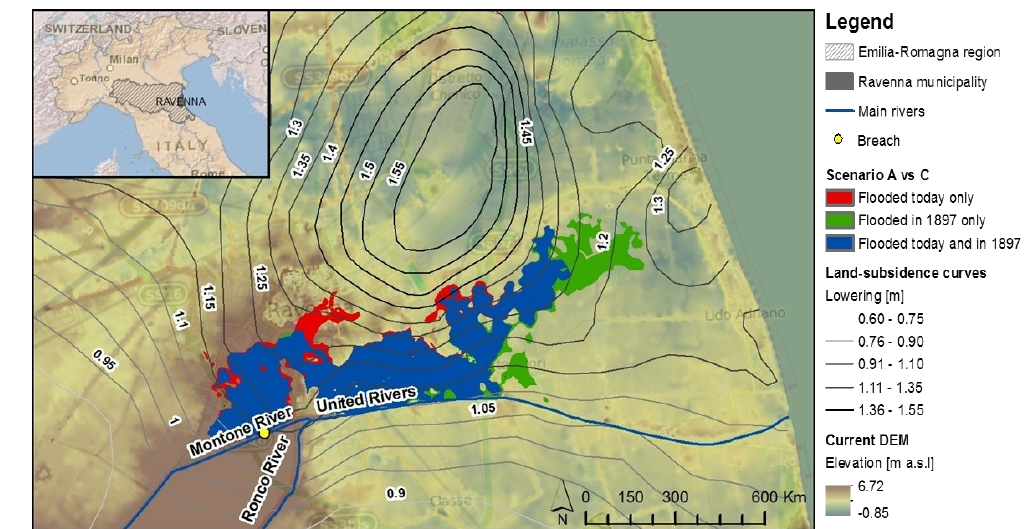
Figure 1. Study area and union of flooded area in scenarios A (current DEM without infrastructures) and C (1897’s DEM without infras- tructures): blue indicates areas flooded in both scenarios, red and green areas are flooded exclusively in Scenario A and C,